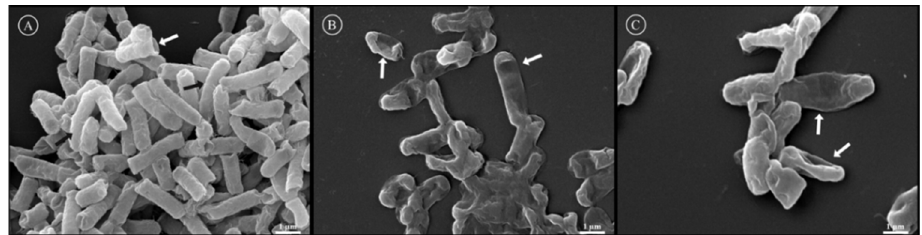
Figure 7. Analysis of the effect of Rsp-3 and -6 on the membrane of Escherichia coli (ATCC 25922) by SEM. ( A ) represents the control group incubated only with water, the white arrow shows the effect of the process of fixation and the black arrow indicates a bacterium with an intact membrane. ( B , C ) represent the effects induced by the presence of Rsp-6 and Rsp-3, respectively, on E. coli membranes, where the white arrows indicate the damages to the membranes by the peptides at the effective concentration of 2 µM.